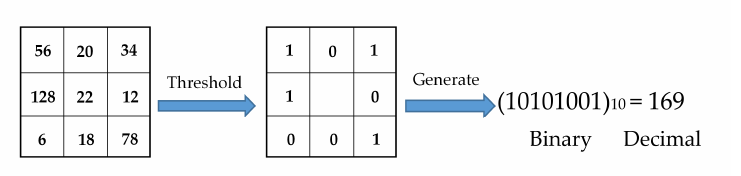
Figure 6. The Local Binary Patterns (LBP) value of the 3 × 3 region.